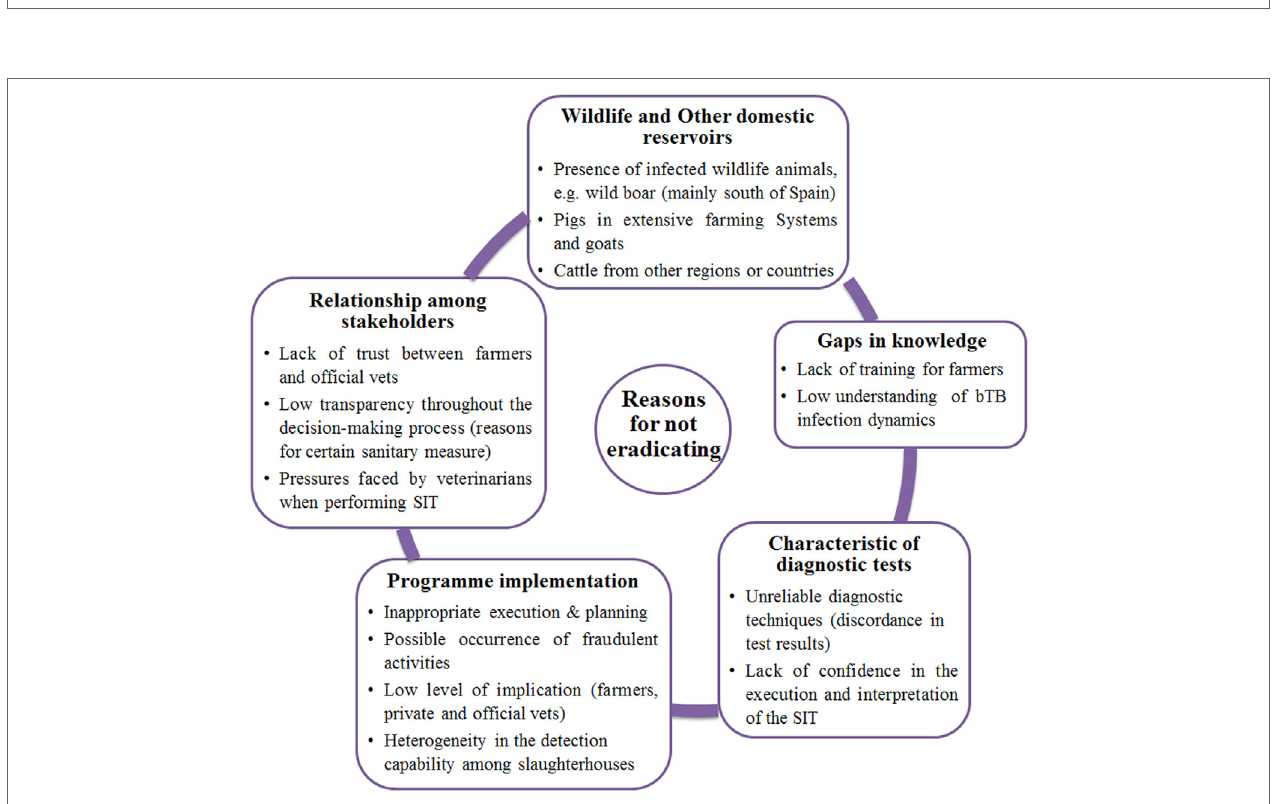
FigUre 4 | Schematic representations of the main themes emerged from exploratory interviews as “Reasons for the failure of bTB eradication”; results for Andalusia and Catalonia are presented together. “vets” = veterinarians; “SIT” = Single Intradermal